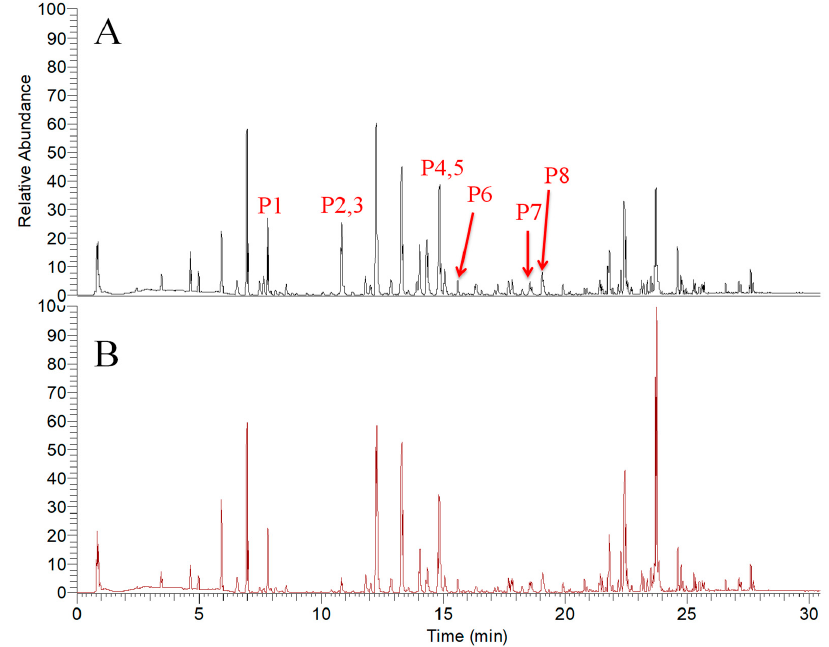
Figure 2. The base peak chromatograms (BPC) of untreated ( A ) and tyrosinase-treated samples ( B ) of A. keiskei in positive ion mode.